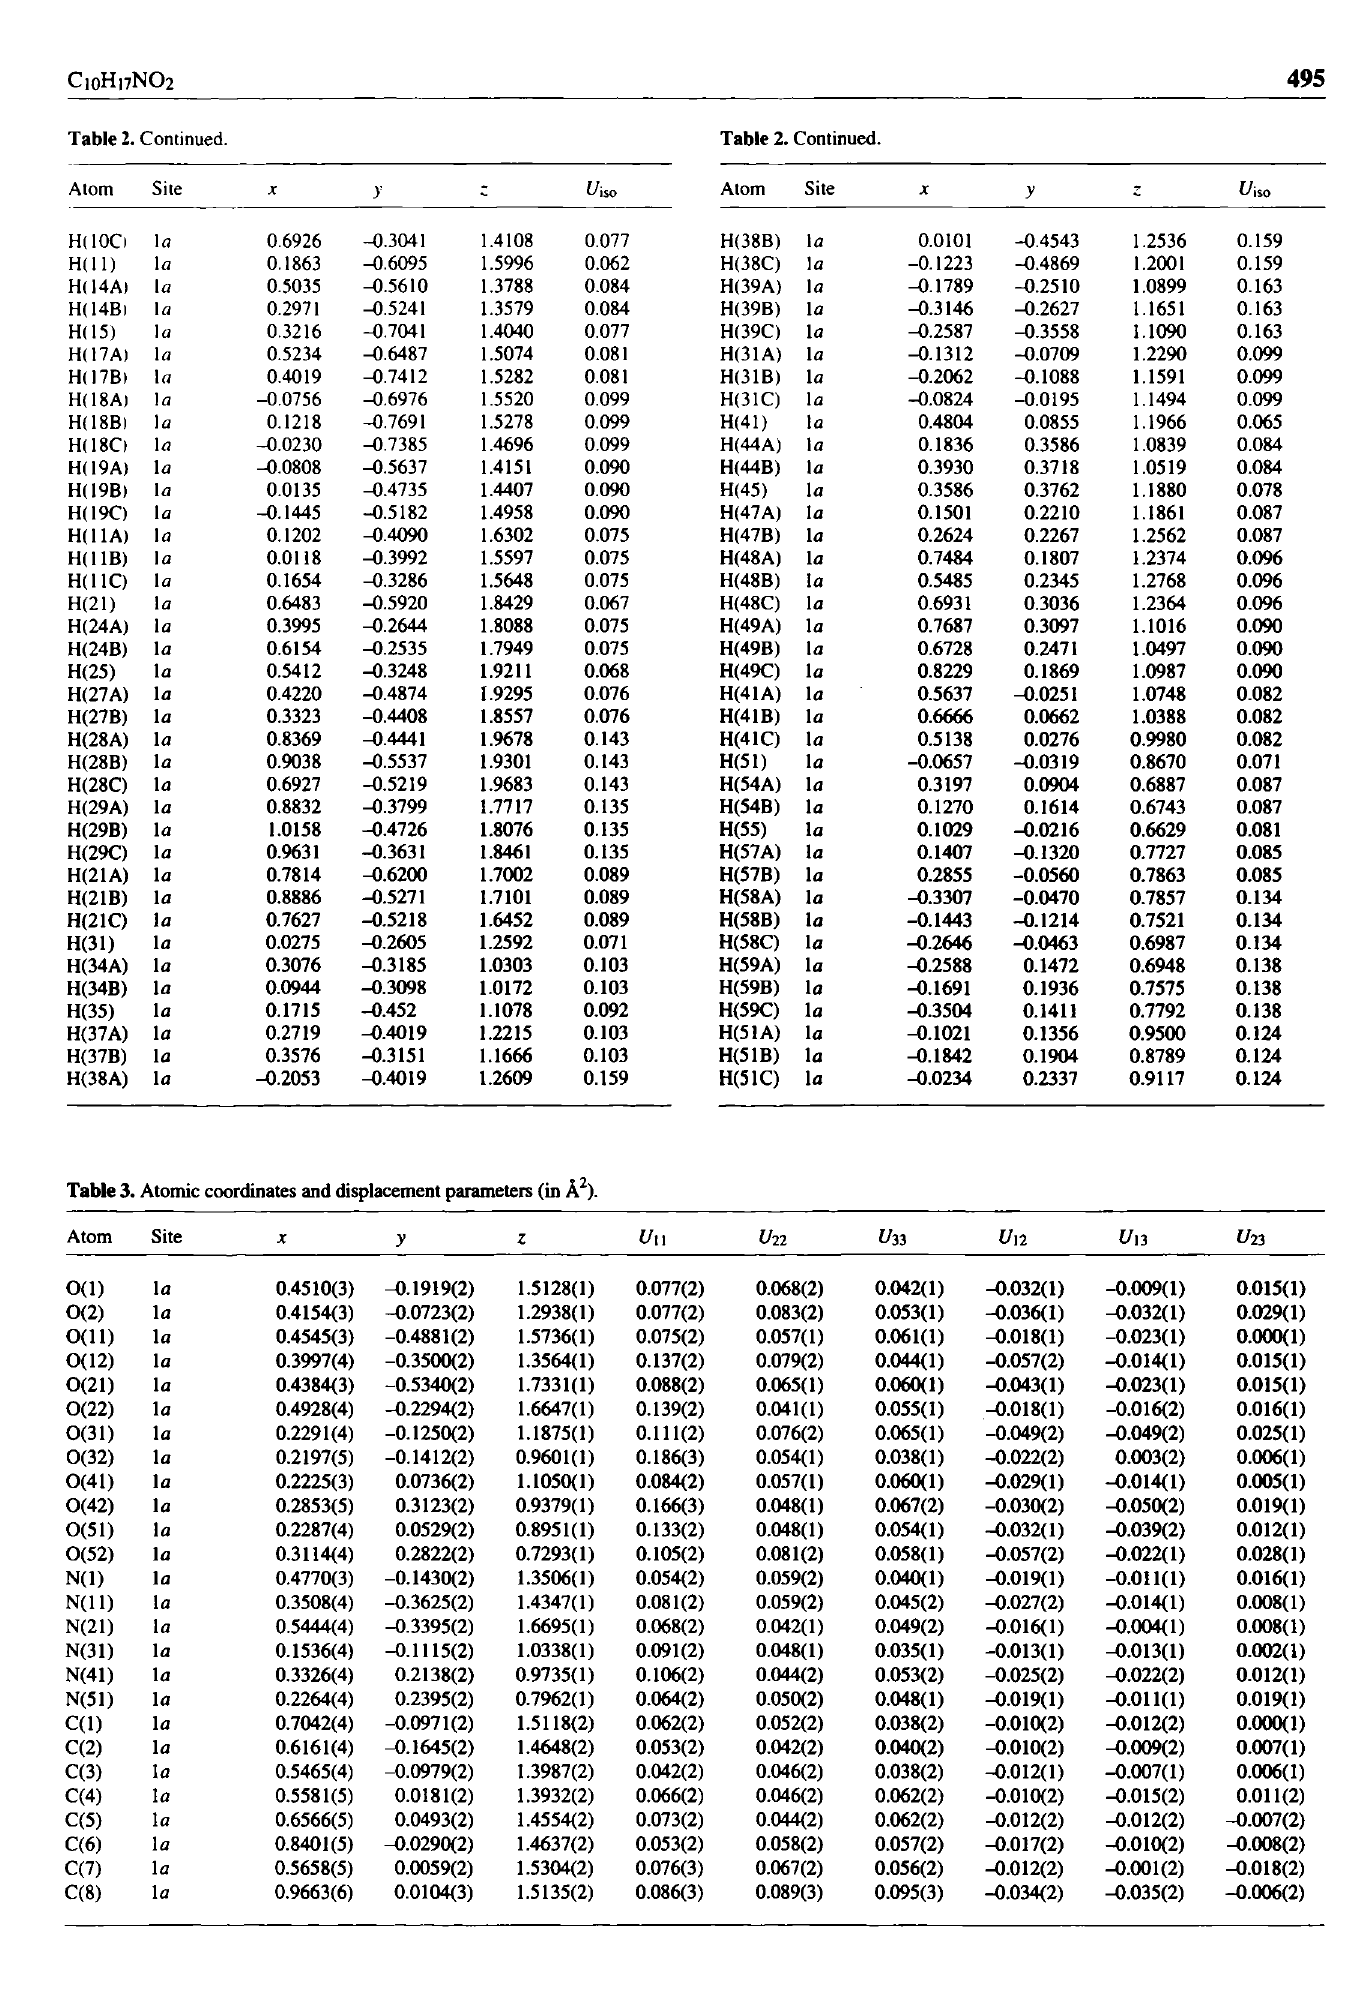
Table 3. Atomic coordinates and displacement parameters (in À 2